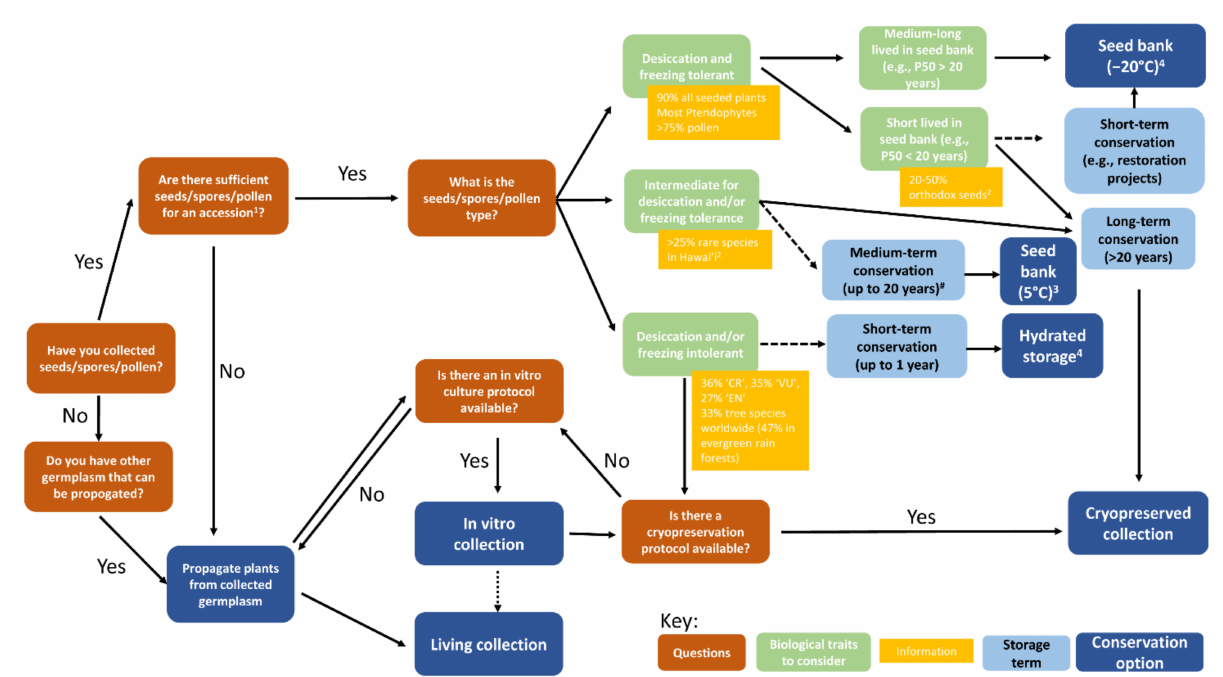
Figure 1. Decision tree showing conservation options depending on the type of germplasm conserved and some of the biological traits associated with different germplasm. Short- and medium-term storage options are indicated by dashed arrows. In vitro collections can be a source of germplasm for living collections (dotted arrow). CR: critically endangered species, EN: endangered species, VU: vulnerable species as per IUCN Red List. # refers only to desiccation tolerant but freezing sensitive seeds. 1 [14–17], 2 [12,18], 3 [19], 4